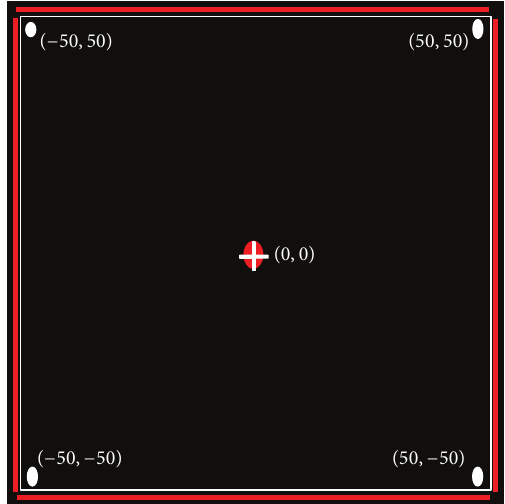
Figure 1: Structure of the